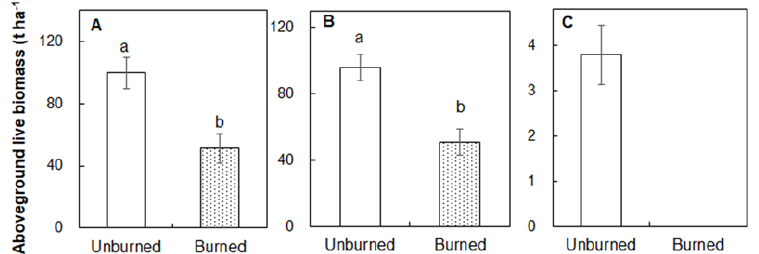
Figure 5. Differences in aboveground live biomass ( A , total; B , tree layer; C , shrub and herbaceous layer) between the unburned and burned plots. Different letters indicate significant differences between treatments at p < 0.05. Values are presented as the means ± standard error.